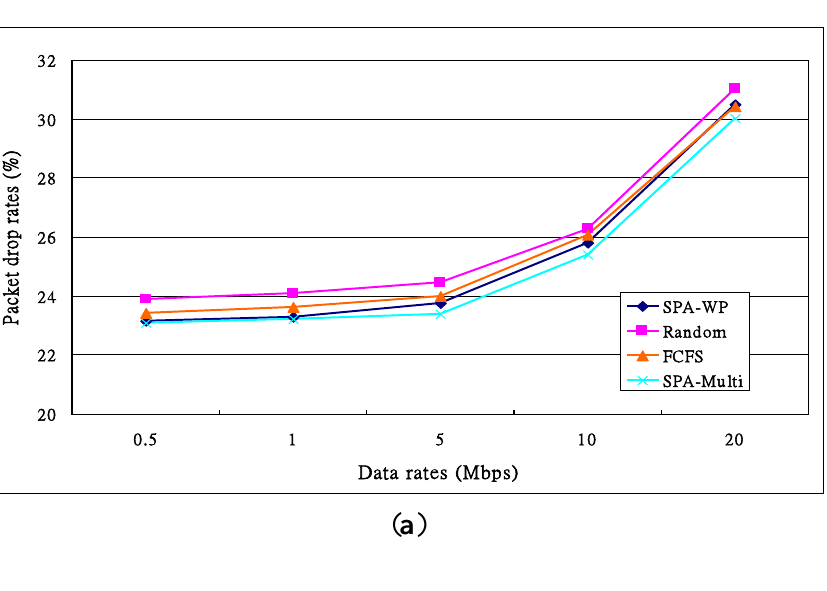
Figure 12. Performance of the third experiment given different packet rates. ( a ) Drop rates; ( b ) Throughputs; ( c ) Turnaround